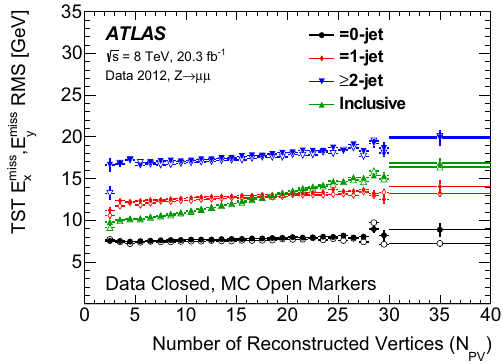
(N0 ) Number of Reconstructed Vertices PV Fig. 8 The resolution of the combined distribution of E miss x and E miss y for the TST E miss as a function of N PV for the 0-jet, 1-jet, ≥ T 2-jet, and inclusive Z → μμ samples. The data ( closed markers ) and MC simulation ( open markers ) are overlaid. The jet counting uses the same JVF criterion as the TST E miss reconstruction T